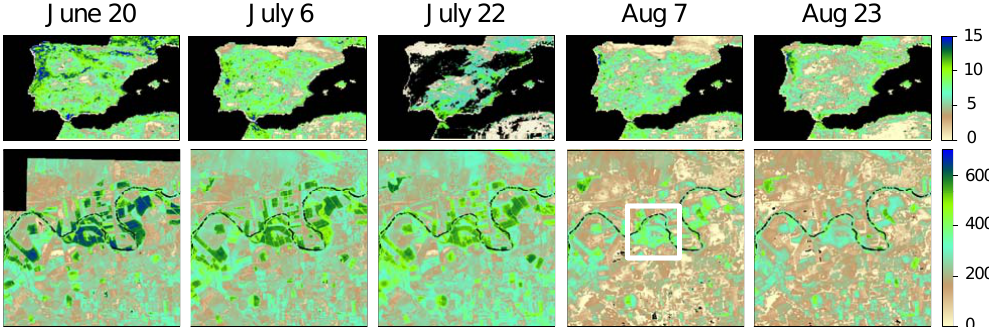
Fig. 8. Maps of daytime ET (MJ m − 2 d − 1 ) from ALEXI over Spain (top row) and instantaneous ET (shortly before local noon; Wm − 2 ) from DisALEXI over an irrigated agricultural area along the Guadalquivir River in southern Spain (bottom row) for five days during the 2009 growing season. White box on the Aug 7 DisALEXI map indicates the 3-km MSG pixel